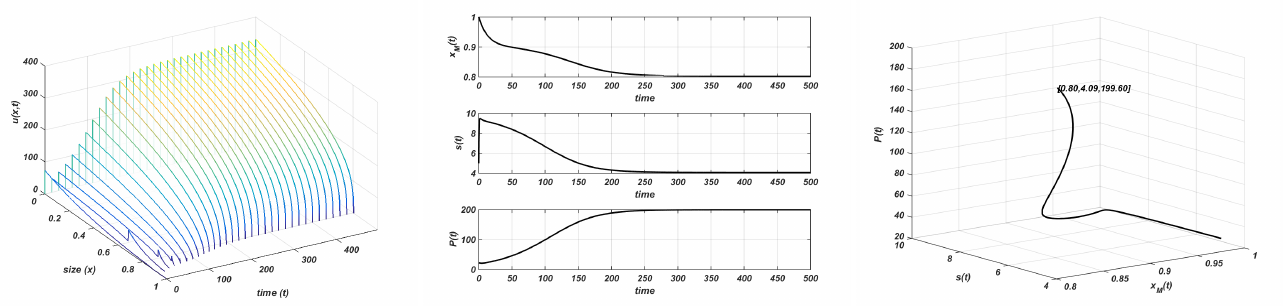
Figure 3. Chemostat growth. r = 4.5 and K = 10. Stable equilibria. Plot on the left : evolution of the structure of the consumer; plot in the centre : evolution of the maximum size, resource, and total consumer population to the equilibrium; plot on the right : orbit followed towards the equilibrium ( 0.80,4.09,199.60 )